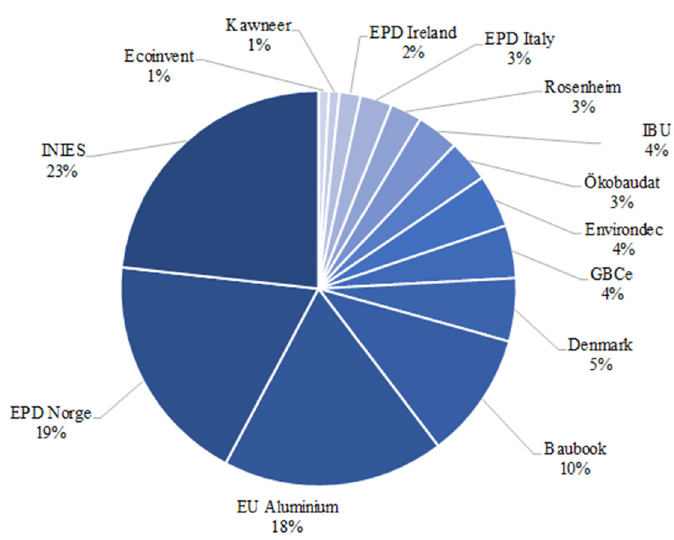
Figure 2. Share of every program operator in the total amount of values analyzed. Table 3 lists the number of PENR, PER or GWP values obtained reporting, for every window typology, the reference database from which data were gathered.